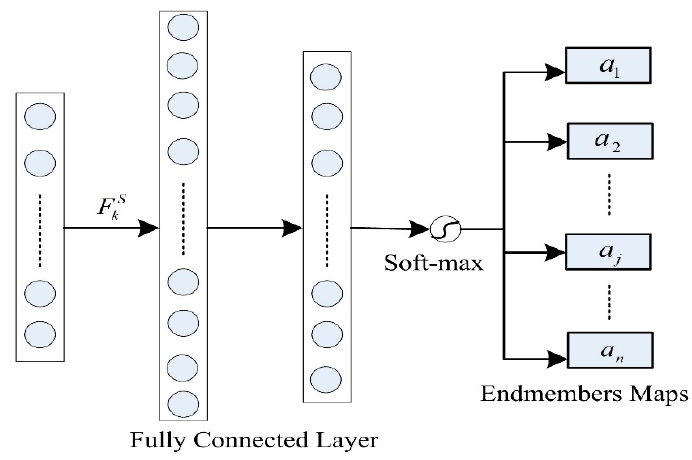
Figure 3. Operation principle of the fully connected layer with scattering transform feature maps.